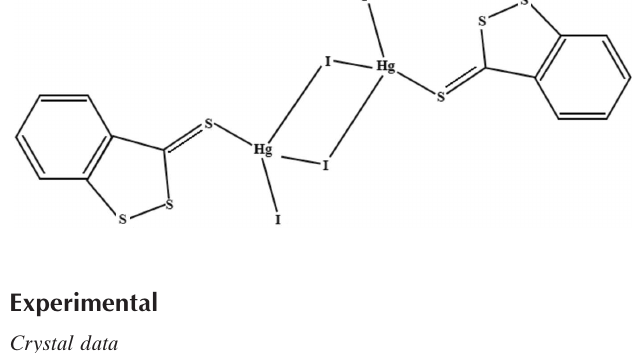
Oxford Diffraction SuperNova diffractometer with an Atlas